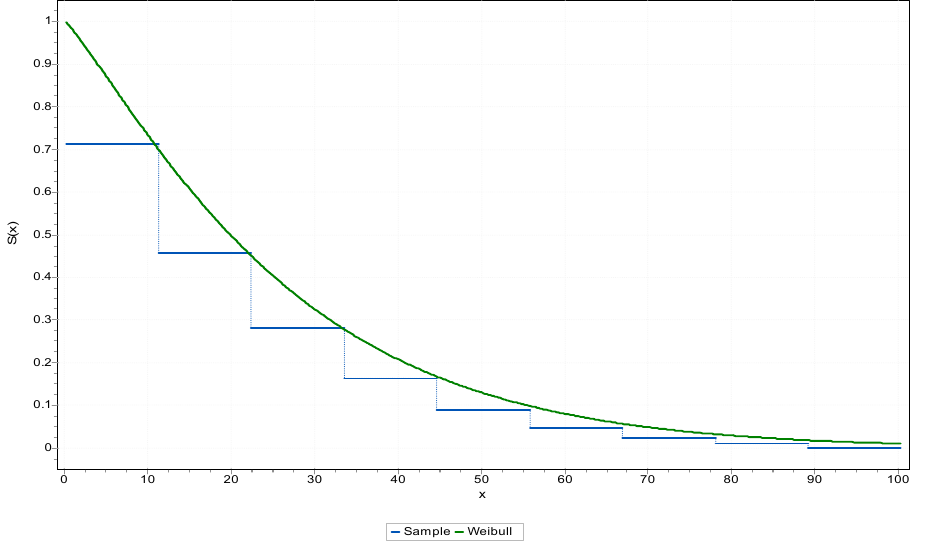
Figure 1. Survival function graph for refrigerator.